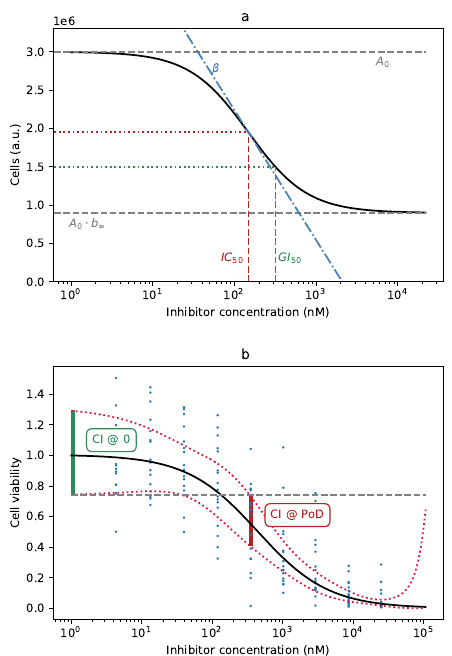
Figure 1. ( a ) Graphical representation of the parameters of the Hill equation: A 0 : the curve upper bound; b ∞ : the curve lower bound, as a fraction of A 0 ; logIC : the logarithm of the substance 50 concentration at the inflection point of the curve, IC 50 ; β : the parameter controlling the slope of the curve. Note that GI 50 is not itself a parameter of the curve; it is the point at which the curve falls to 50% of its maximum value, A 0 . ( b ) Definition of the point-of-departure (PoD), based on the confidence band of the curve. The existence of a drug effect can be established with 95% confidence at the lowest concentration at which the Hill curve’s confidence interval (CI, red) does not overlap with the 95% CI at logC = 0